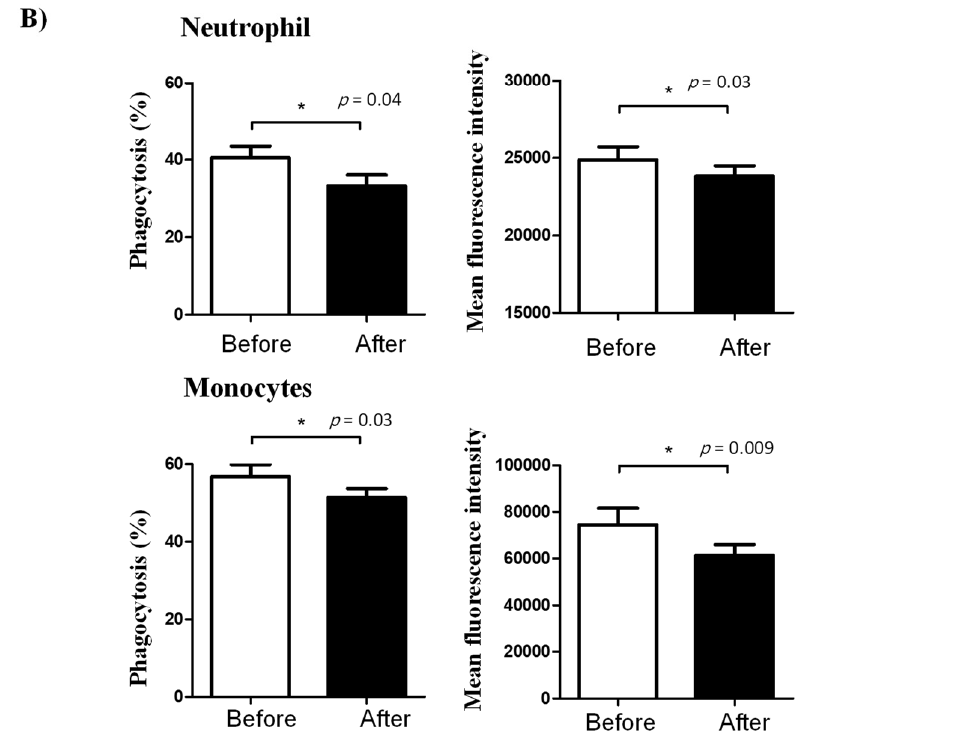
Figure 4. Ex vivo analysis of the phagocytosis activity of camel neutrophils and monocytes. Separated leukocytes were stimulated with FITC-labeled bacteria ( S. aureus) and the immunofluorescence signals were detected by flow cytometry. ( A ) After gating on neutrophils and monocytes, the fraction and the MFI of phagocytosing cells were determined based on the increased green fluorescence in FL-1. ( B ) Data were presented for neutrophils and monocytes from camels before and after treatment with lornoxicam and were presented as means ± SEM. Differences between the means were considered significant (*) if p < 0.05.